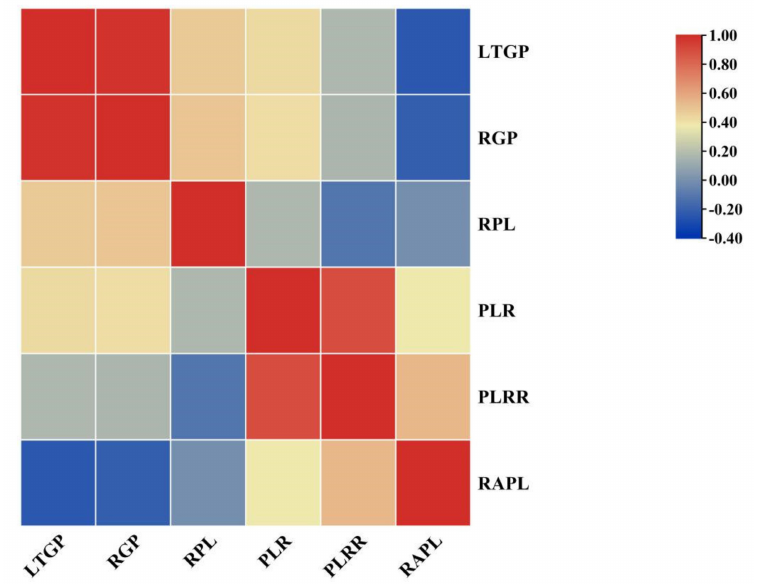
Figure 3. Heat maps of correlations between six LTG indices. Blocks that tend to be red or blue indicate greater absolute values of the correlation